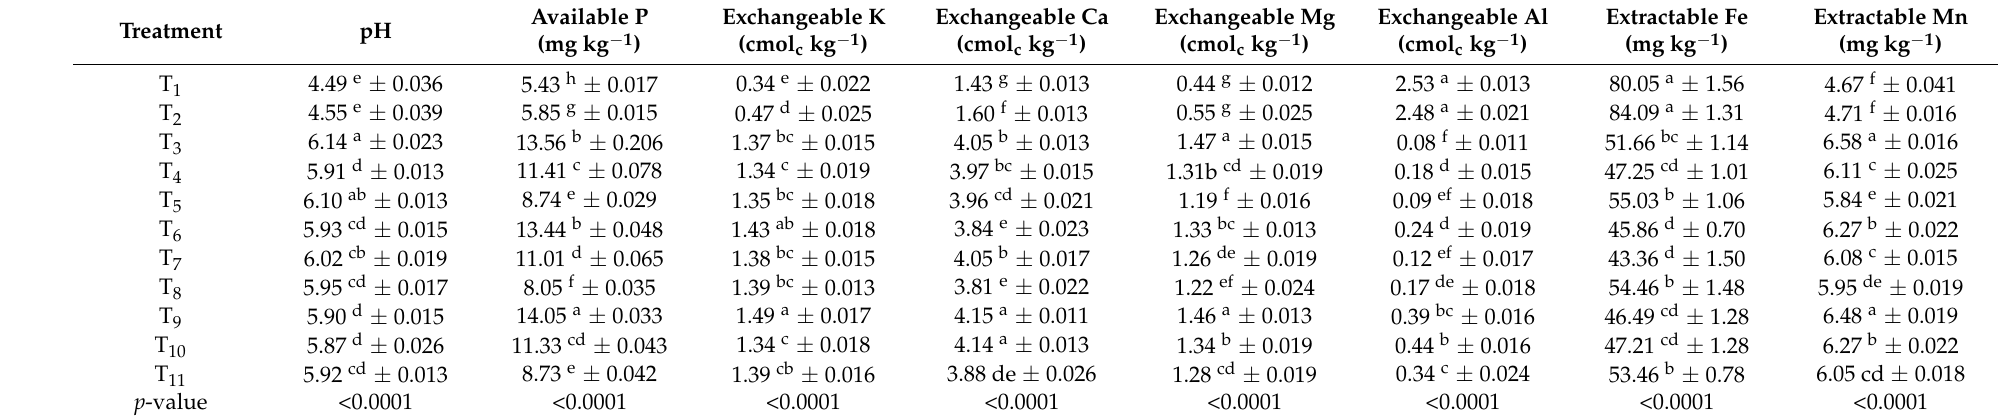
Table 4. Effect of treatments on changes in nutrients of the post-harvest